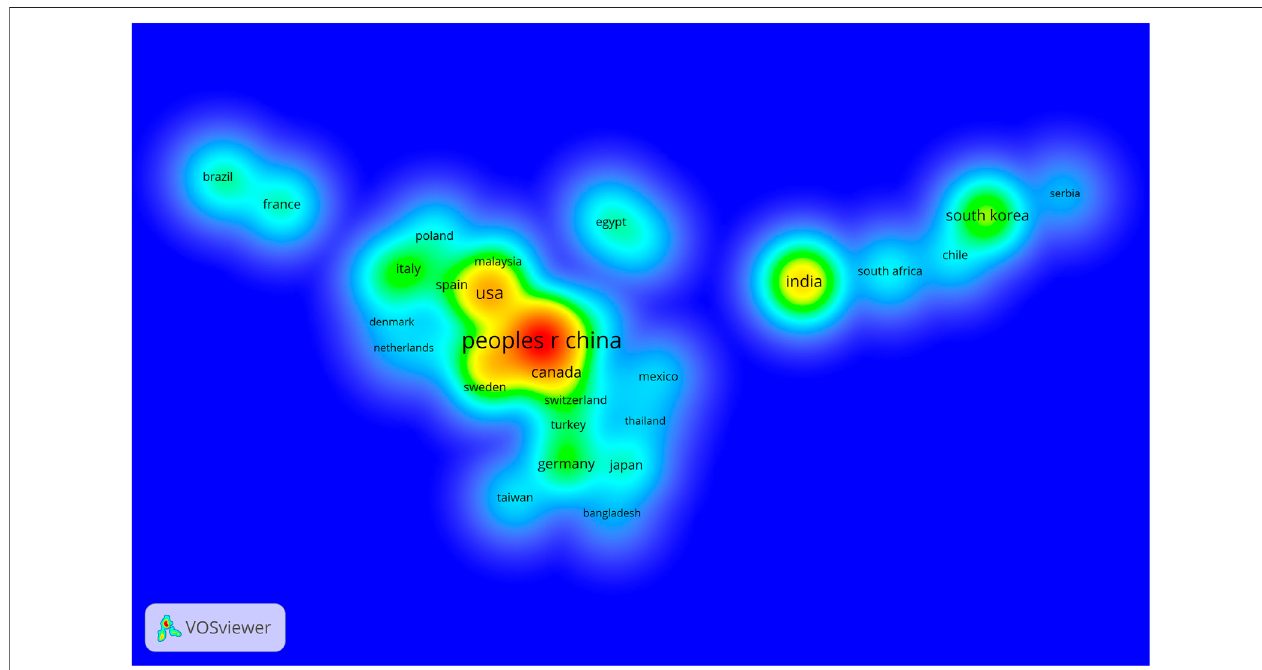
FIGURE 2 | Visualized map of quantity of publication which is based on nanocomposite hydrogel and related research issued by countries and the density of co- author relationship.